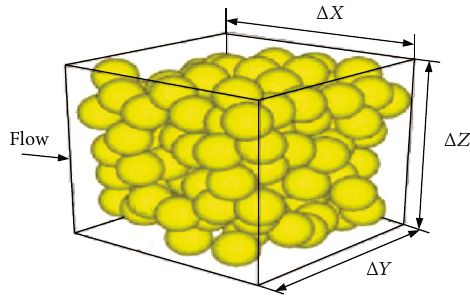
Figure 1: Fluid through the particle